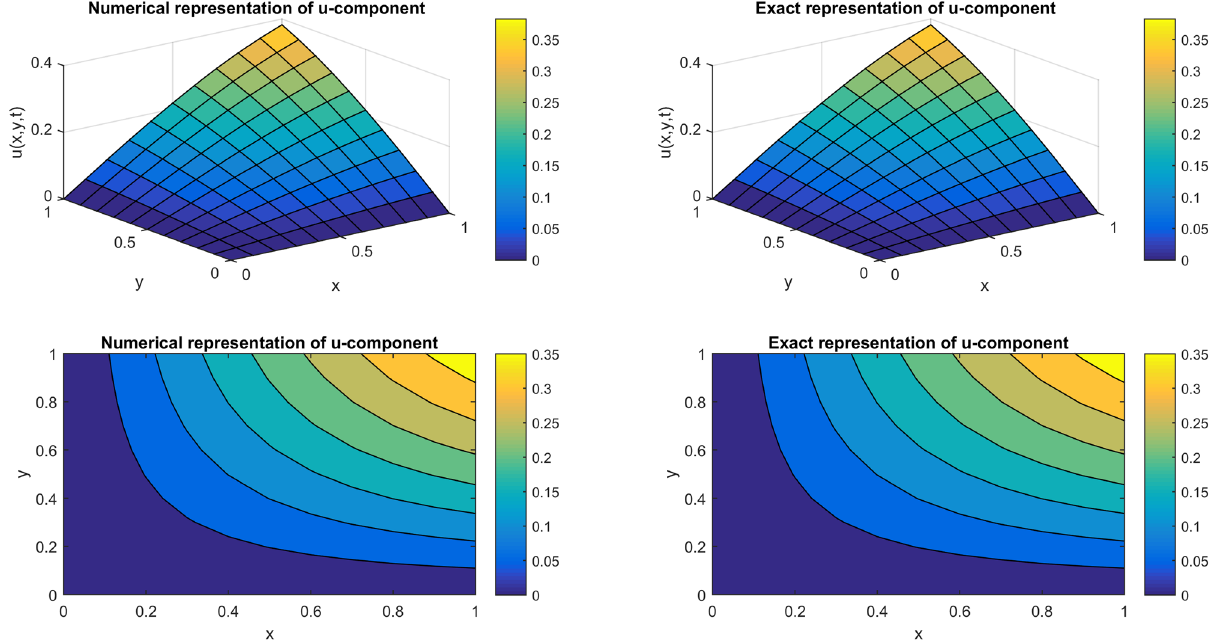
Figure 9: Surface and contour representation of ( ) u x t , at t = 1 with = N 11 , = α 1 , = β 1 , = τ 0.5 , and = t Δ 0.0001 using Method I regarding Example 5.